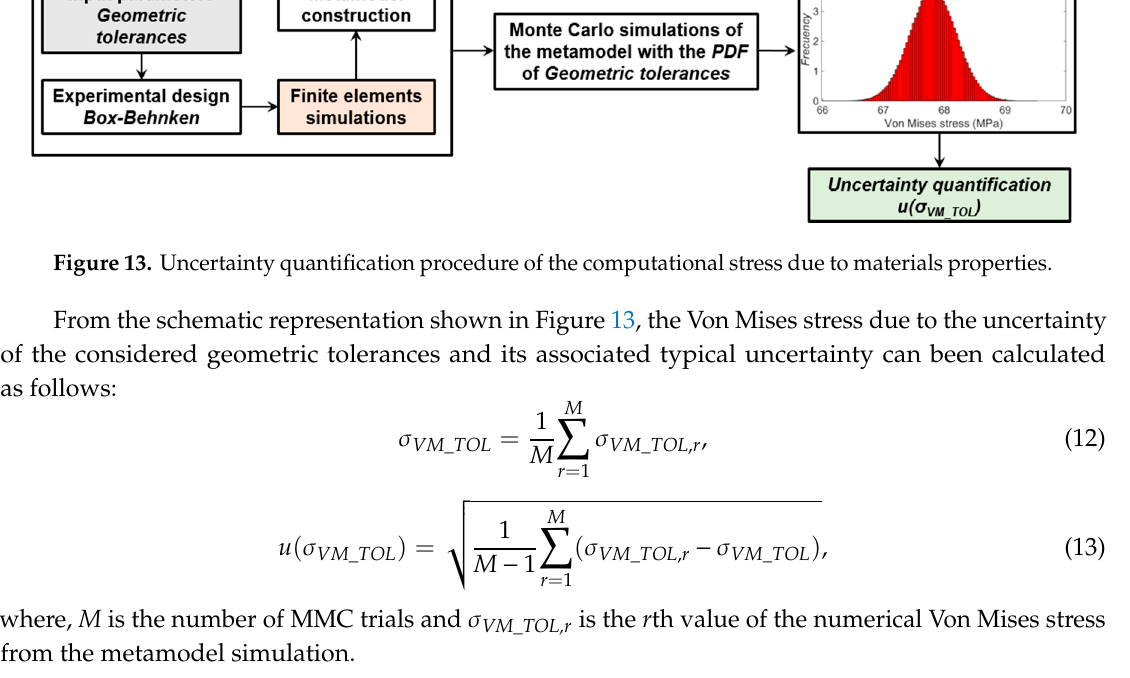
Table 5. Experimental design based in the geometric tolerance values.